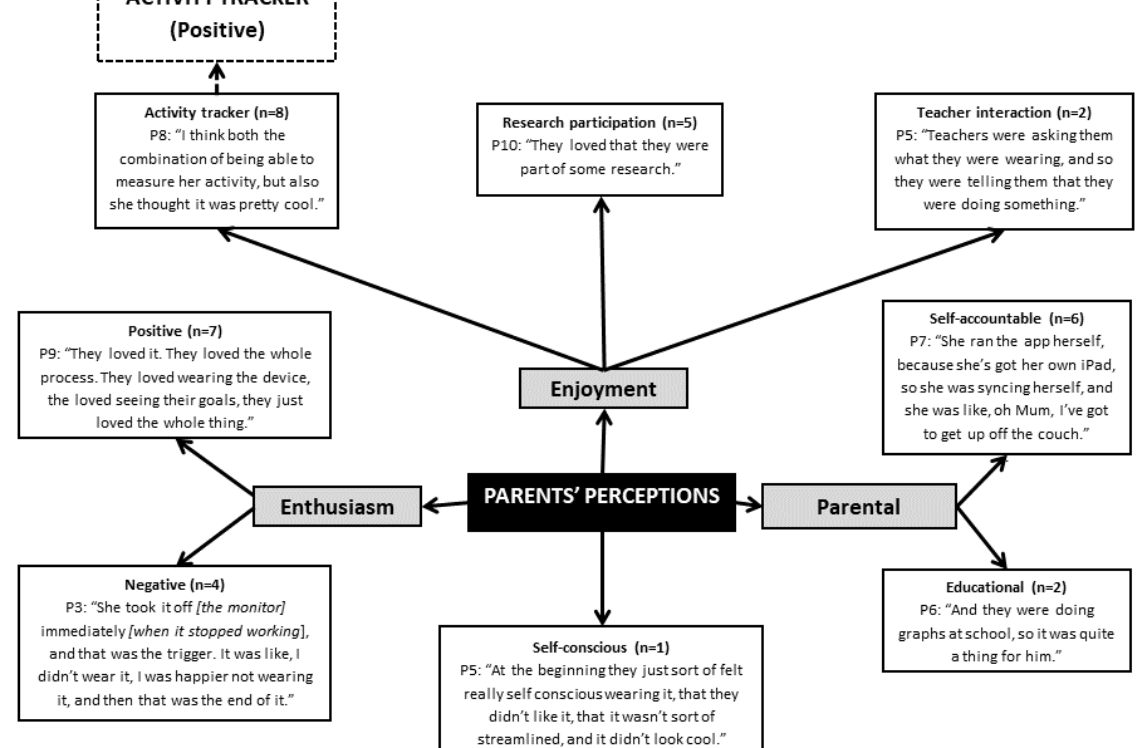
Figure 4. Parents’ (P) perceptions on children’s use of the wearable activity tracker. The dashed line indicates link made between different themes noted by the researchers from the points discussed, rather than directly mentioned by the